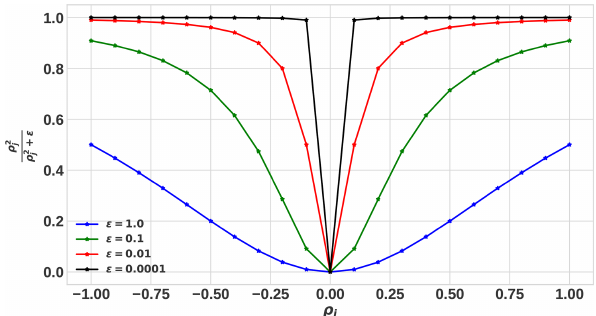
Figure 2. Comparison of the minimum-support stabilizing function for different values of ε